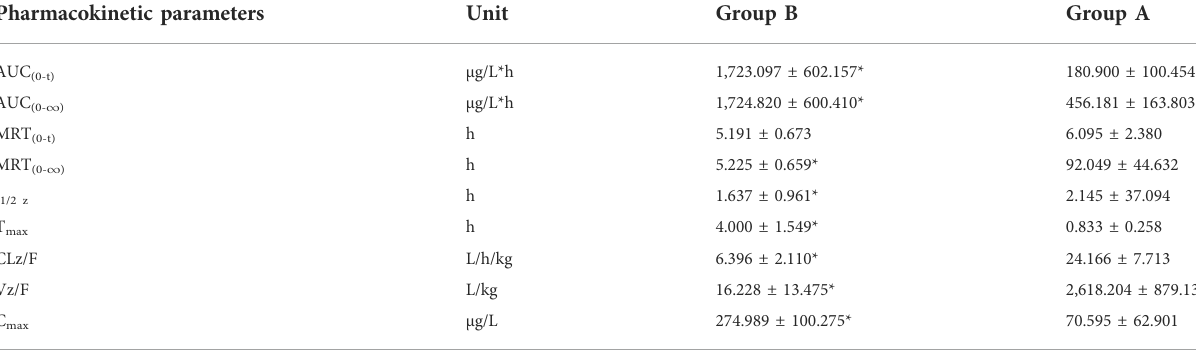
TABLE 3 Pharmacokinetic parameters of fl uvoxamine. Pharmacokinetic